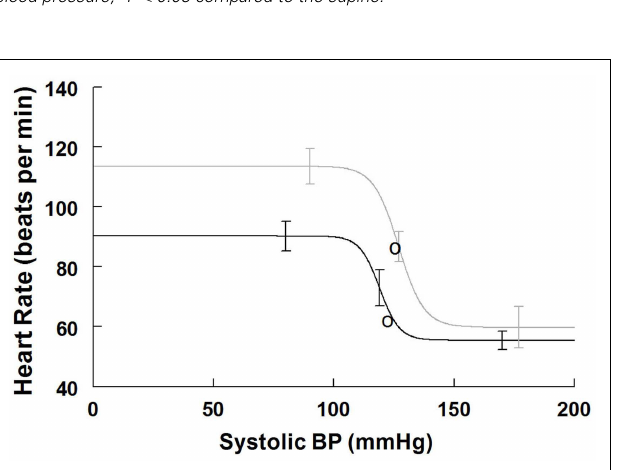
FIGURE 3 | Supine and upright cardiovagal baroreflex relationships were obtained by averaging data-fits over all subjects during the Oxford maneuver. The upright curve is shifted upwards and to the right from supine but the maximum slope (sensitivity) is unaffected by posture.